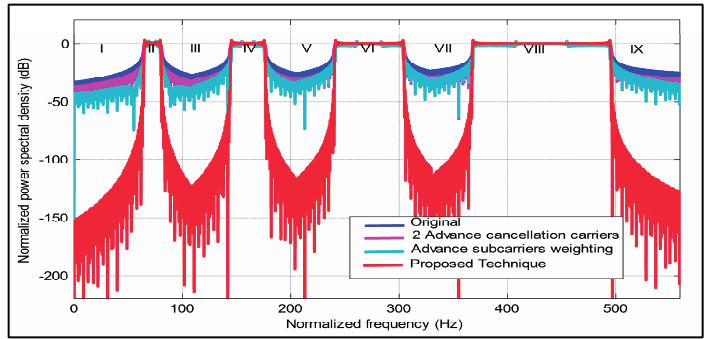
Figure 8. The PSD comparison between the proposed technique and existing techniques including ACC and ASW.